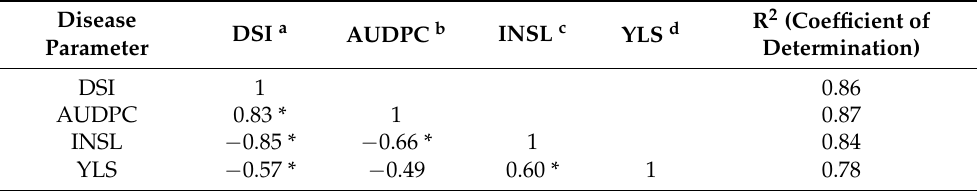
Table 2. Correlation matrix and coefficient of determination of parameters used to evaluate Matooke hybrids (NARITAs) and banana varieties for response to black